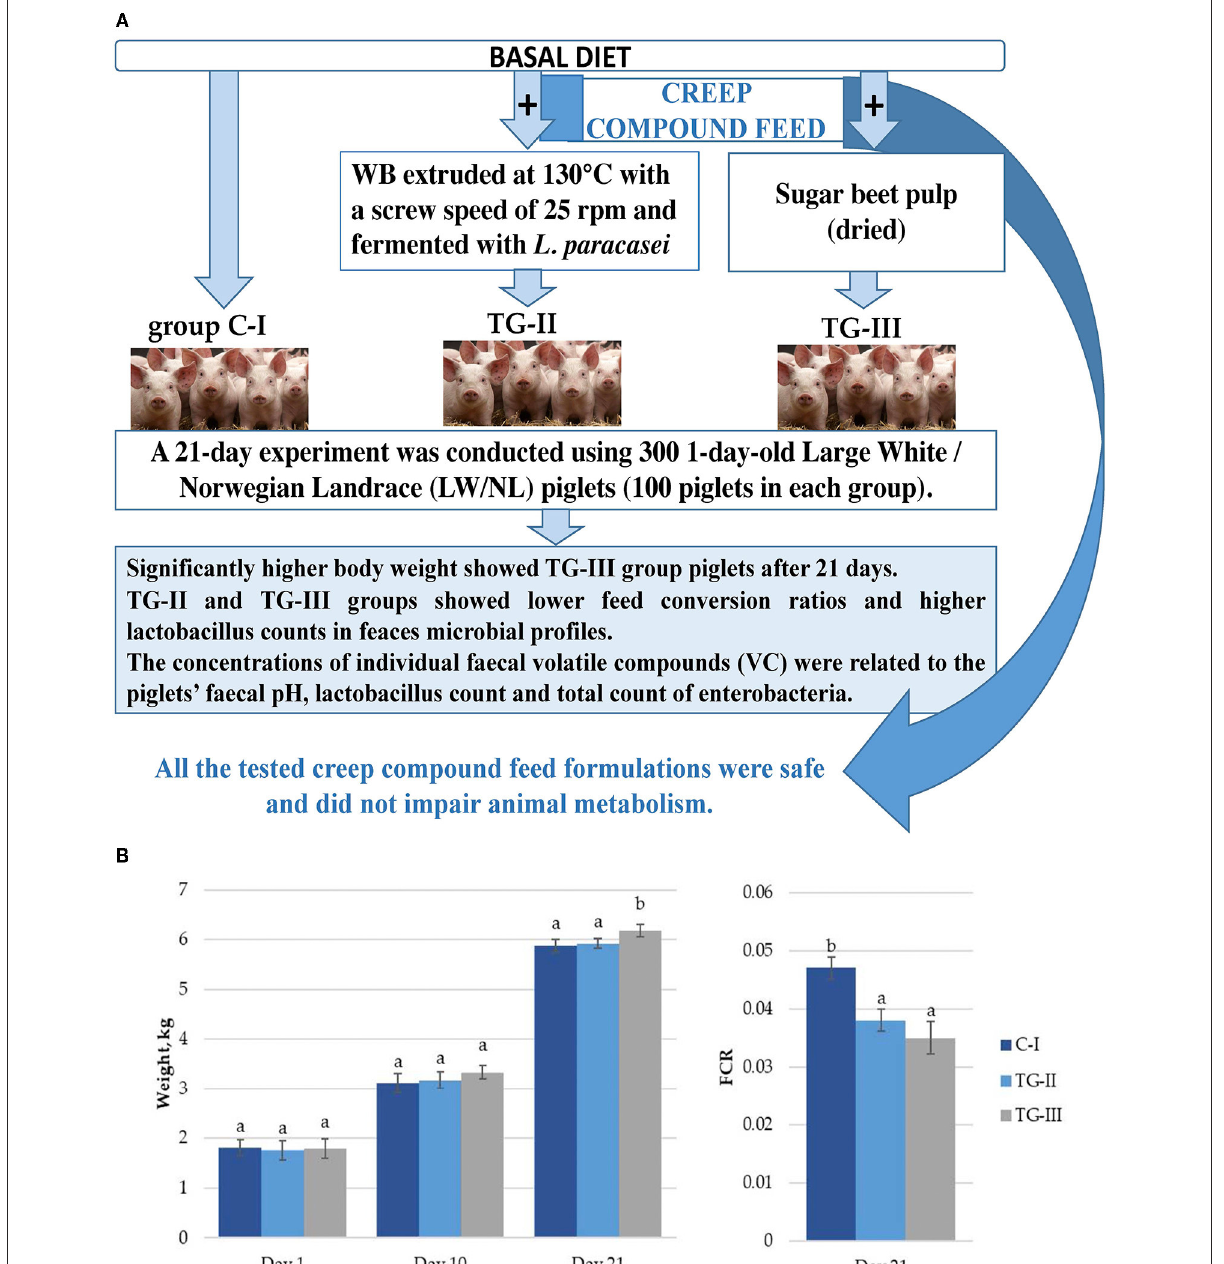
FIGURE1 (A) Piglet weight; (B) Feed conversion ratio (FCR) ( a,b different letters indicate differences among treatments ( p < 0.05); (i) basal diet (C-I – control group), (ii) basal diet with extruded-fermented wheat bran added (TG-II), (iii) basal diet with dried sugar beet pulp (TG-III). The data are presented as the mean ± standard error ( n = 100/group).